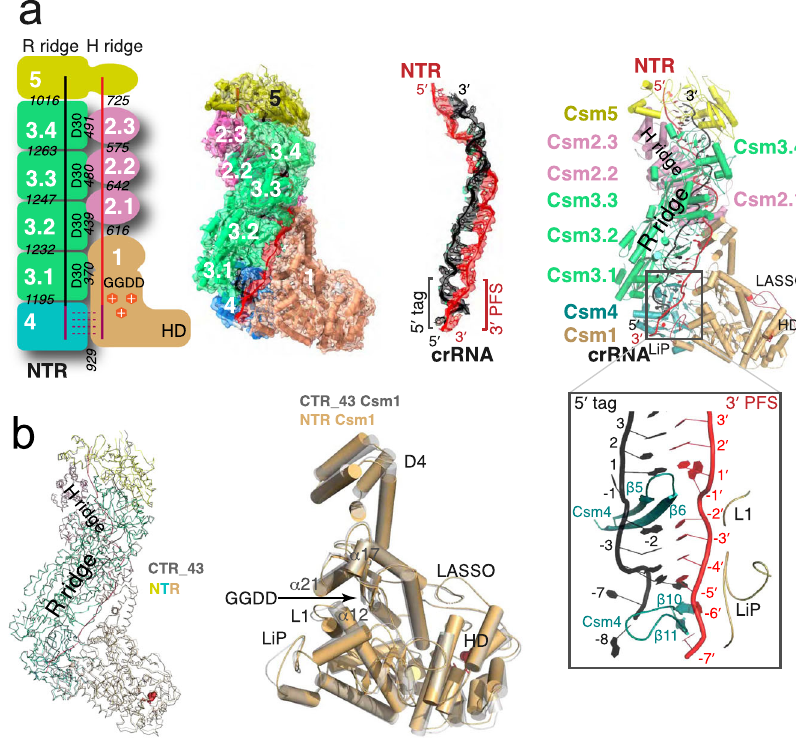
Fig. 3 Structure of the non-cognate target RNA (NTR)-bound LlCsm complex. Numbers in white indicate names of the subunit where N or N.m represent CsmN (or the mth CsmN). Key secondary elements are labeled. The crRNA and CTR are colored black and red, respectively. a Schematic representation and electron potential density of NTR complex with stoichiometry 1 1 2 3 3 4 4 1 5 1 crRNA 1 Target 1 . Italicized numbers in black indicate the buried solvent- accessible surface of the corresponding subunits in Å 2 . The relative locations of crRNA 5 ′ -tag and the NTR 3 ′ -PFS are highlighted. The boxed image displays the base-paired 5 ′ -tag and 3 ′ -PFS surrounded by Csm4 and Csm1 structural elements. b Comparison of CTR-43 and NTR complex in ribbon representations. The Csm3 subunits of the two complexes are superimposed to reveal, if any, differences in other subunits. Csm1 subunits from both complexes are compared in a cartoon representation. Note the different locations of the LiP loop in the two